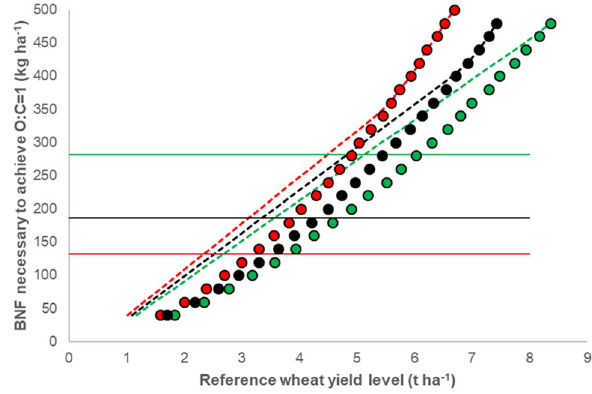
Figure 5. Biological nitrogen fixation (kg ha −1 N) necessary to achieve a yield OC-ratio of 1 depending on conventional reference yield level. Proportion of area grown with legume flexible (symbols) or capped at 0.33 (dashed lines); removal of N with the wheat grain from the field (as determined by the percentage of N in the grain) is low (green symbols and dashed lines), medium (black) or high (red). Horizontal lines correspond to upper quartile (green), median (black) and lower quartile (red) of empirical BNF